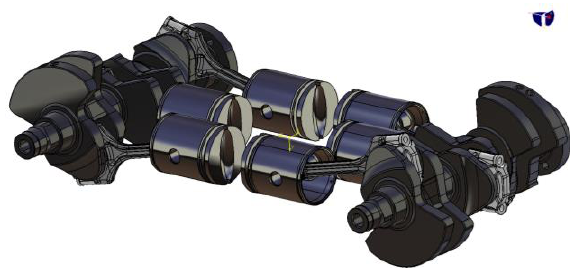
Fig. 1. Model of crank-piston system of PZL-100 engine in CAD envi-